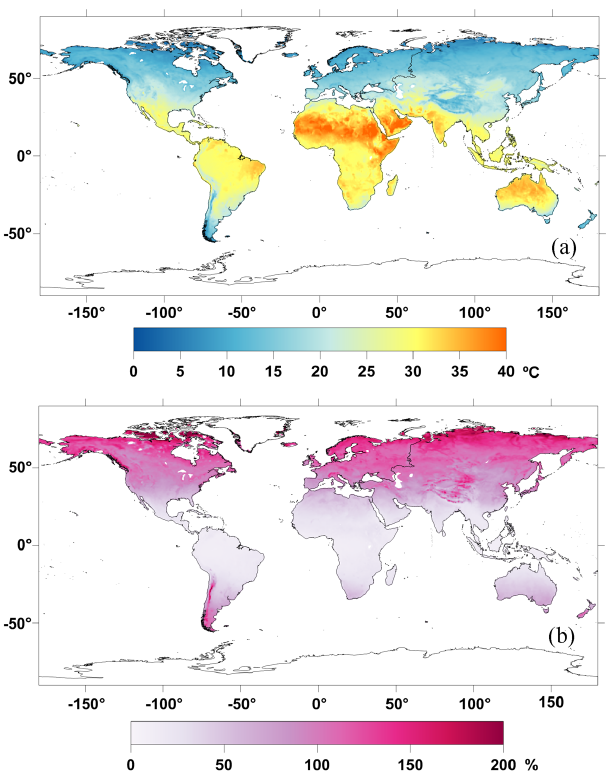
Figure 6. LPDR T mx mean (a) and 2 times the coefficient of varia- tion (b) for the years 2003–2010 and 2013–2015.